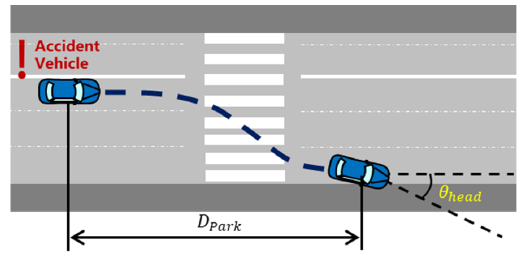
Figure 14. An illustration of parking distance and final heading angle.